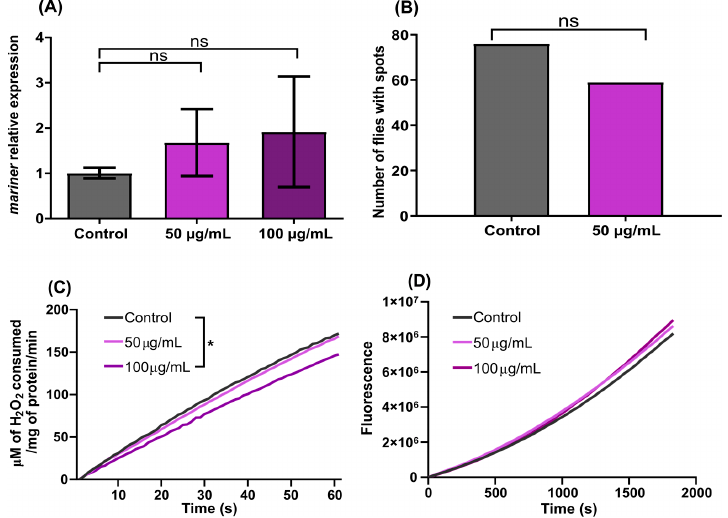
Figure 3. Effects of dacarbazine in D. simulans w pch . ( A ) Relative expression of the mariner TE in flies exposed to 50 and 100 µg/mL dacarbazine. ( B ) Number of flies with red spots in the eyes after chronic exposure to 50 µg/mL dacarbazine. ( C ) Monitoring of catalase activity after 24 h of exposure to 50 or 100 µg/mL dacarbazine. ( D ) Monitoring of ROS content in flies after 24 h of exposure to 50 or 100 µg/mL dacarbazine. Data were analyzed by two-way ANOVA, followed by Tukey’s post hoc test. * Mean values are significantly different compared to Control. Ns = non significant. There was a significant ( p = 0.0133) decrease in catalase activity between the flies exposed to 100 µg/mL dacarbazine and the control group (Figure 3C). There was no difference in catalase activity or between the two concentrations in the flies treated with 50 µg/mL dacarbazine. Moreover, the flies treated with both concentrations of dacarbazine showed no significant change in fluorescence values for the DCFDA assay ( p > 0.05) compared to the control group (Figure 3D). 3.3. Daunorubicin Exposure to daunorubicin for 24 h significantly ( p = 0.0004) increased the relative expression of the mariner gene at both concentrations compared with the control group (Figure 4A). In contrast, chronic exposure significantly decreased mariner-peach SM expression despite the increase in relative expression of mariner ( p = 0.0232, Figure 4B).